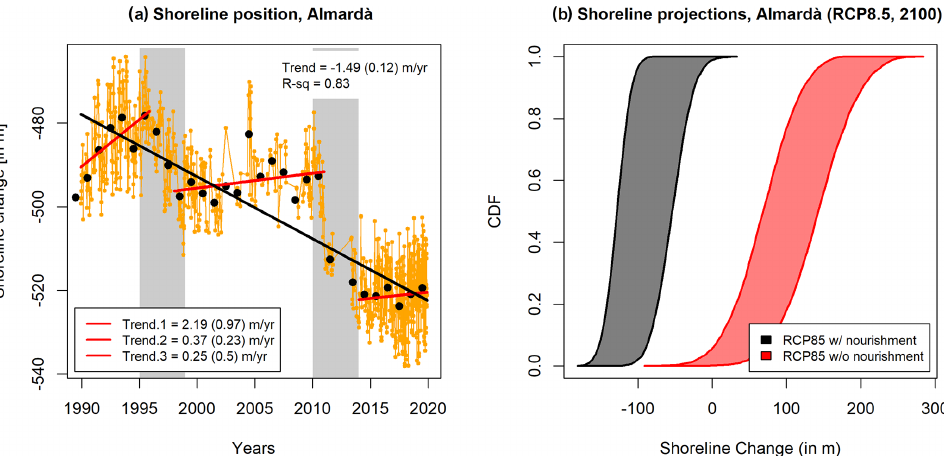
Figure 9. (a) Observed shoreline change evolution in Almardà. The black and red lines indicate trends computed with and without, respec- tively, the periods of beach nourishment, which are displayed in grey. (b) Probability boxes of projected shoreline change by 2100 under the RCP8.5 scenarios with (black) and without (red) including beach